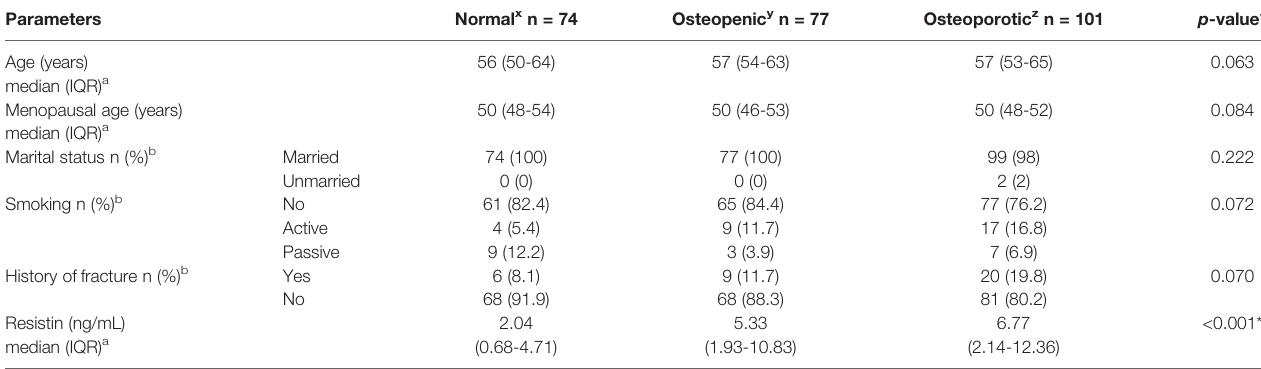
TABLE 1 | General characteristics of the study